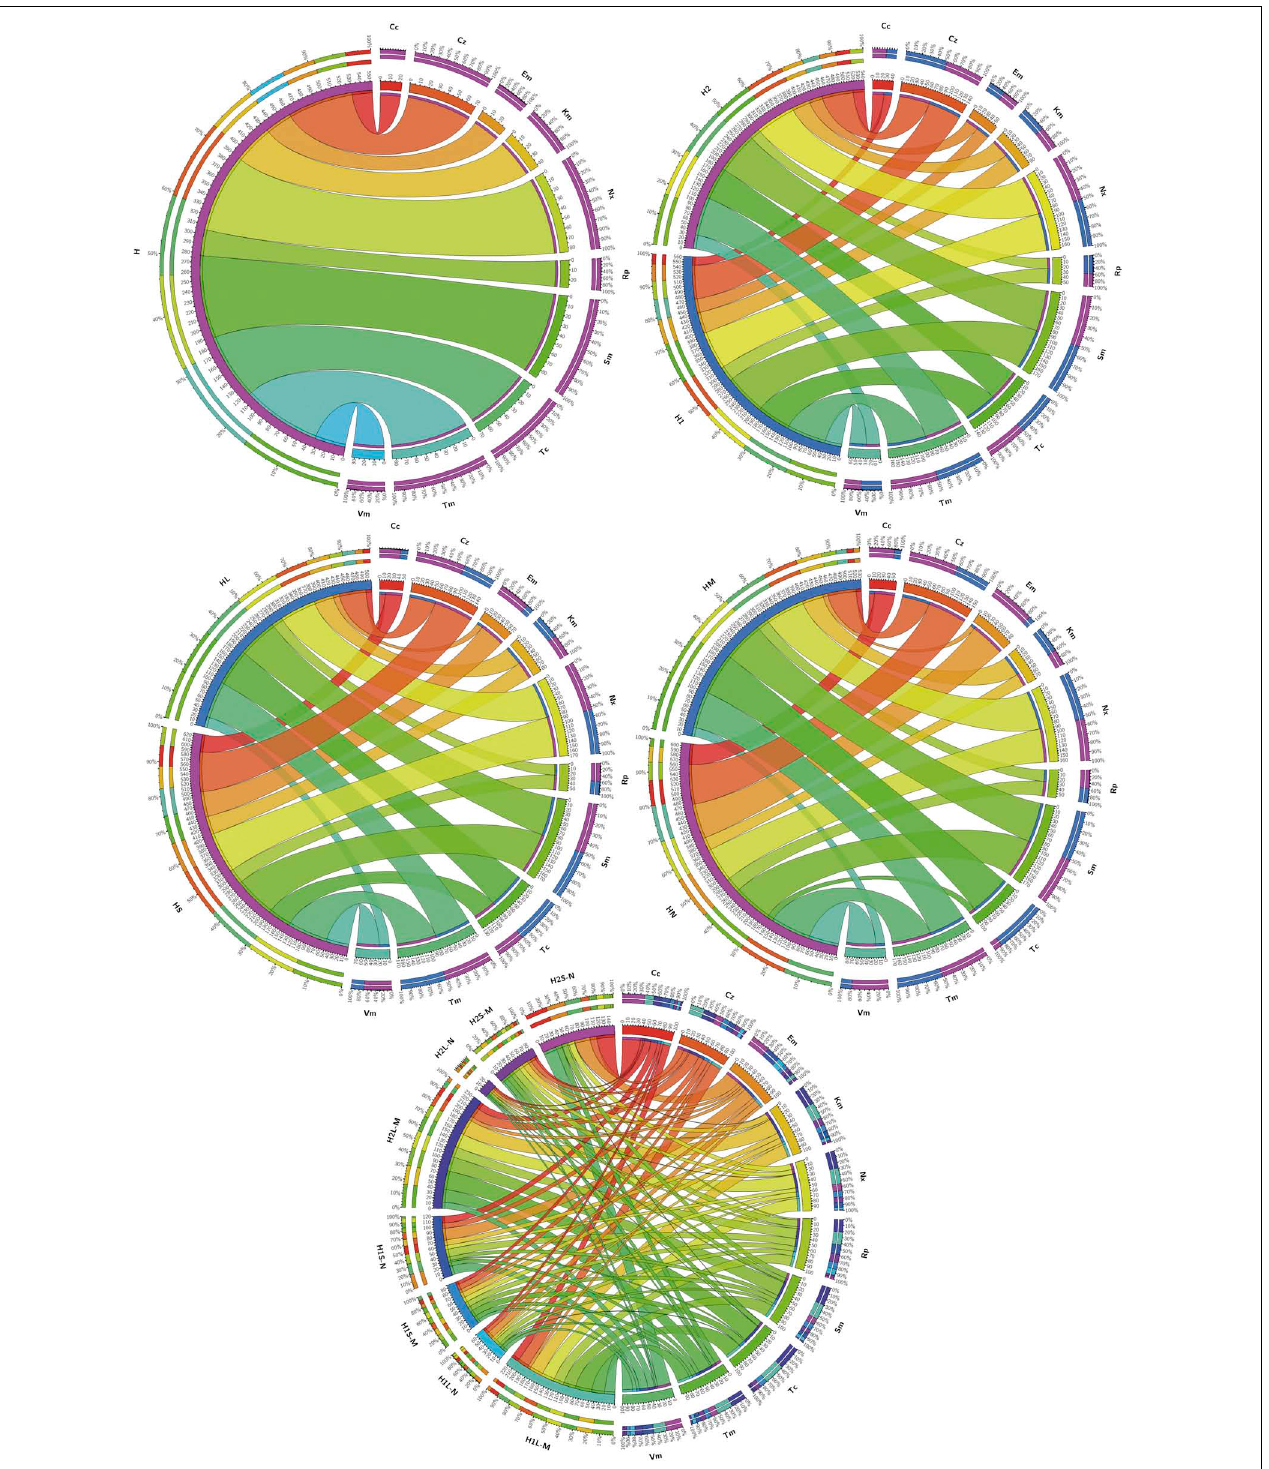
FIGURE 3 | Prevalence of isolates resistant to the different antibiotics tested in the indicated groups of isolates. Considered groups of isolates were H: all, H1 and H2: all from both sampling sites independently, HL and HS: all from waters and sediments, respectively, HM and HN: all obtained from marine and nutritive media, respectively, and H1L-M, H1L-N, H1S-M, H1S-N, H2L-M, H2L-N, H2S-M, and H2S-N: groups considering independently sampling zones, phases and media. Ribbons connect antibiotic to which resistant isolates have been found and the groups of isolates in which they were found. Ribbons wideness represents percentages of bacteria resistant to the corresponding antibiotic among the isolates of the corresponding considered group.